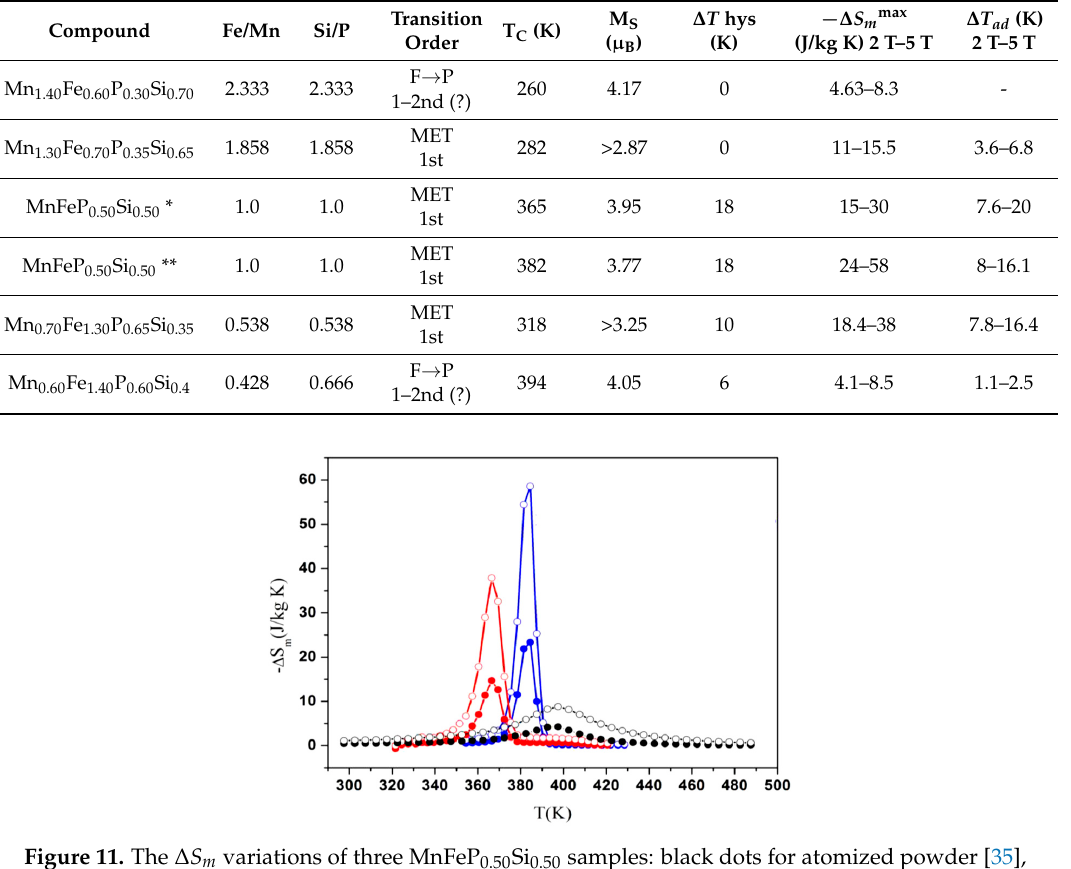
Table 3. Main magnetic and magnetocaloric characteristics measured on six members of the series